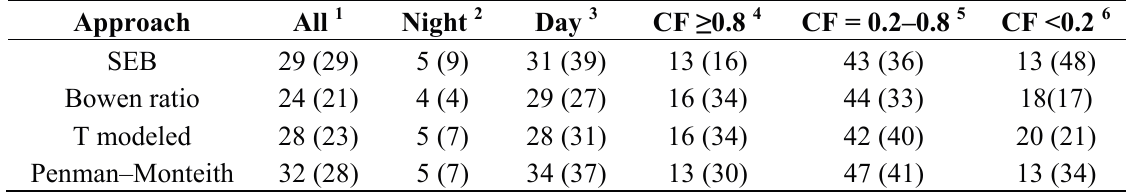
Table 4. As in Table 3, but for model estimates using T